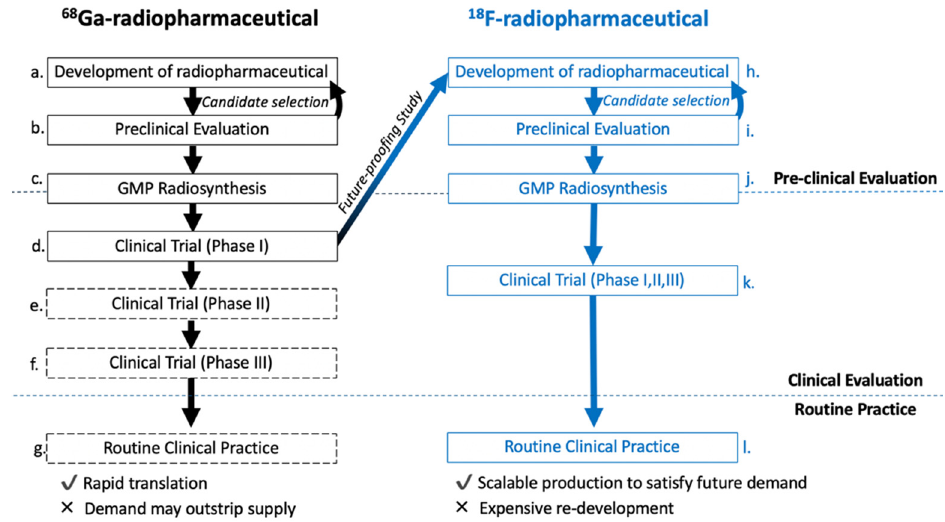
Figure 1. Proposed workflow for the development of gallium-68 radiopharmaceuticals alongside complementary fluorine-18 analogues.